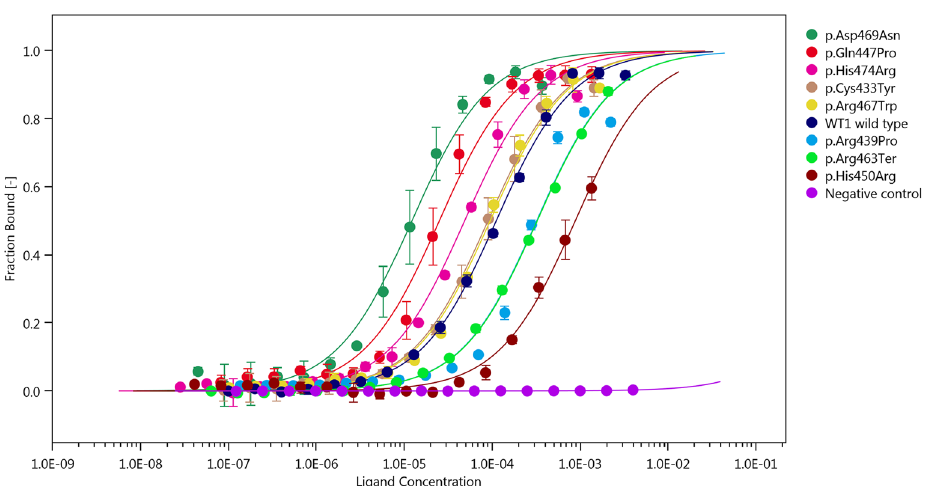
Figure 1. Binding affinity curves of all tested WT1 proteins. The relative amount of WT1 protein bound to the EGR1 DNA motif (fraction bound, y axis) analyzed by microscale thermophoresis. With increasing protein concentration (x axis) the bond becomes saturated (y axis). Shift to the left from the wild type (dark blue) reflects an increased binding affinity, while shift to the right means a decreased affinity. Bovine serum albumin (purple) was used as a negative control. All proteins measured in